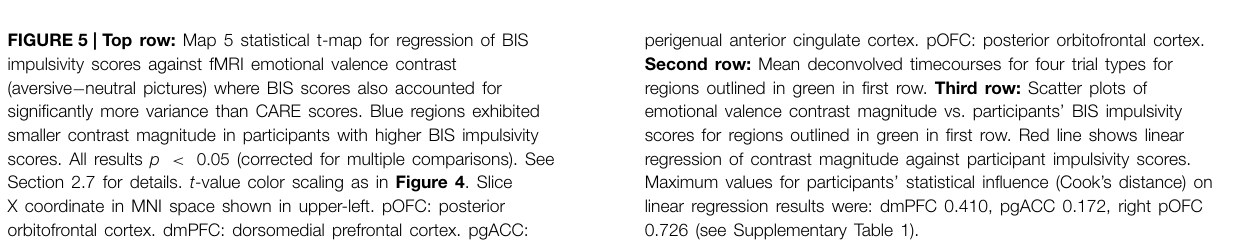
perigenual anterior cingulate cortex. pOFC: posterior orbitofrontal cortex. Second row: Mean deconvolved timecourses for four trial types for regions outlined in green in first row. Third row: Scatter plots of emotional valence contrast magnitude vs. participants’ BIS impulsivity scores for regions outlined in green in first row. Red line shows linear regression of contrast magnitude against participant impulsivity scores. Maximum values for participants’ statistical influence (Cook’s distance) on linear regression results were: dmPFC 0.410, pgACC 0.172, right pOFC 0.726 (see Supplementary Table